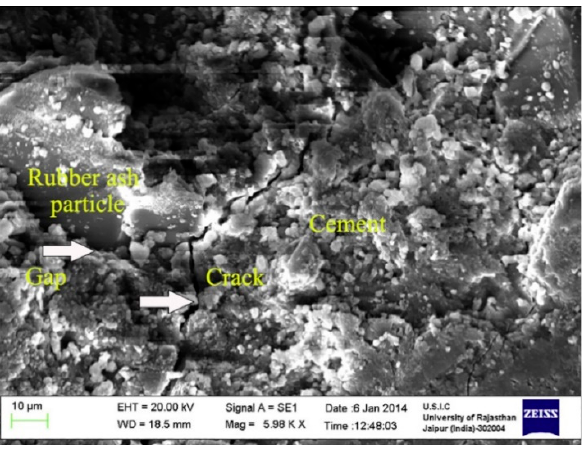
Figure 6. Microstructure of RC containing 20% rubber ash [49].